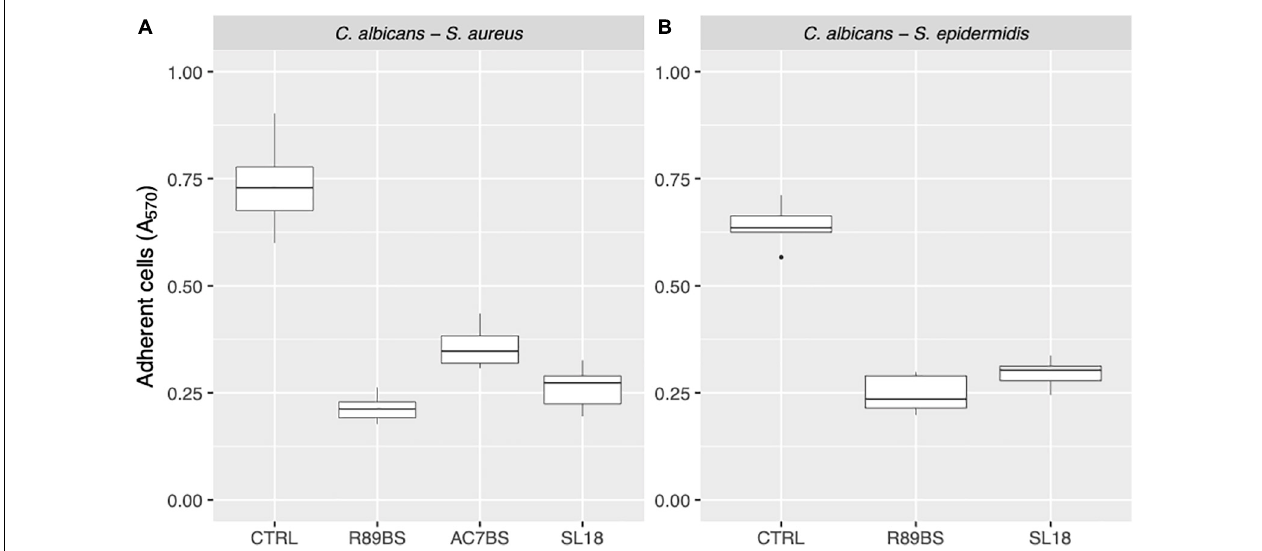
FIGURE 6 | Anti-adhesive activity of the BSs coated silicone discs. The efficacy of the BSs surface treatment was evaluated in terms of C. albicans – S. aureus (A) and C. albicans – S. epidermidis (B) adherent cells after 4 h of